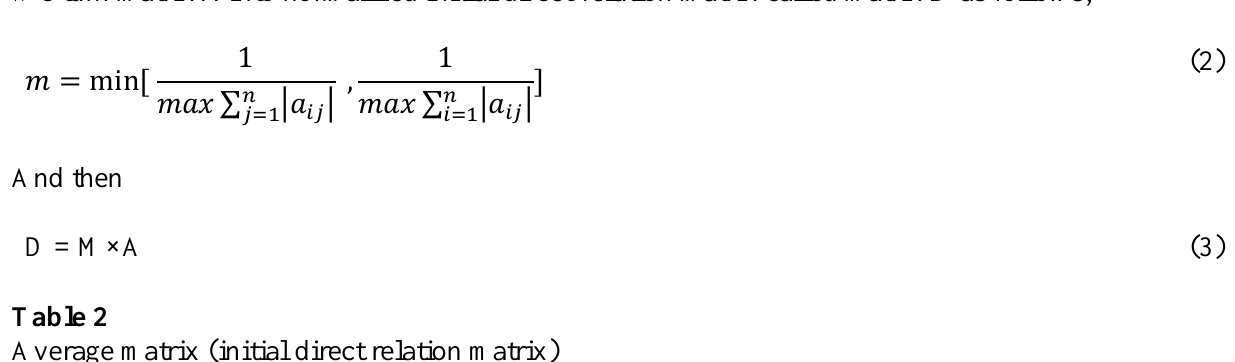
Average matrix (initial direct relation matrix)